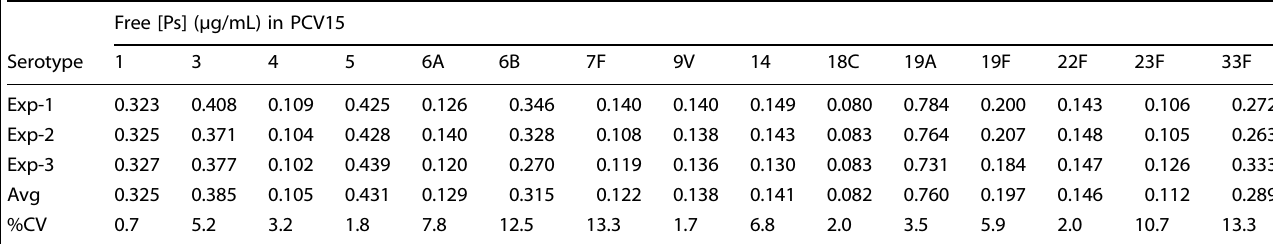
Table 3. Precision for free Ps quantitation.